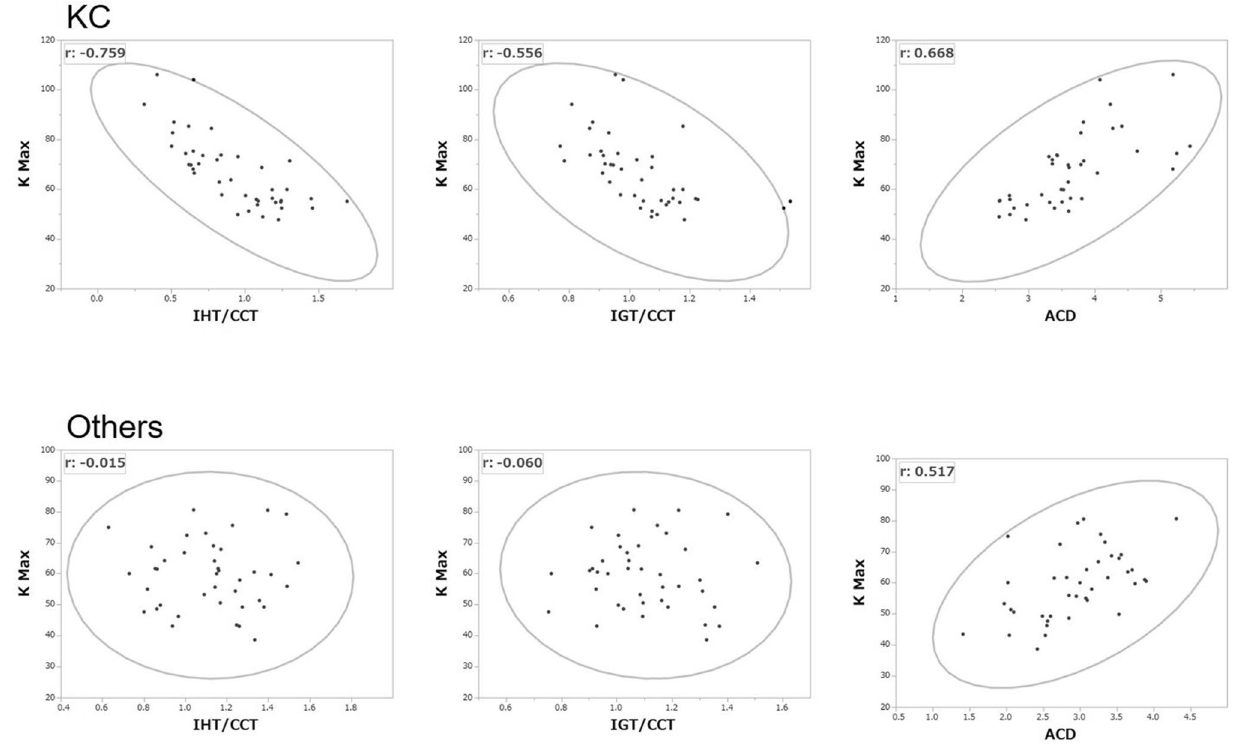
Figure 3. Scatterplots of K max and the corneal ectasia indicators (IHT/CCT, IGT/CCT, and ACD) in the KC (upper graphs) and Others (lower graphs) groups. K max was strongly correlated with host and graft thinning in